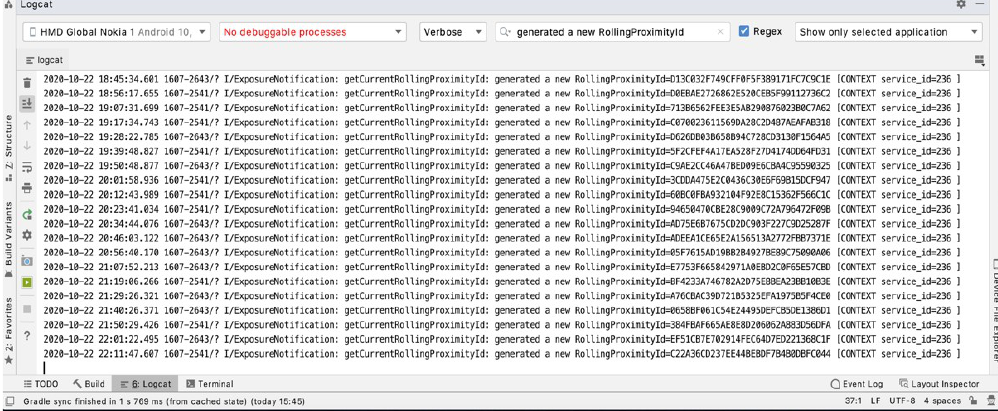
Figure 2. Time interval of RPI change.